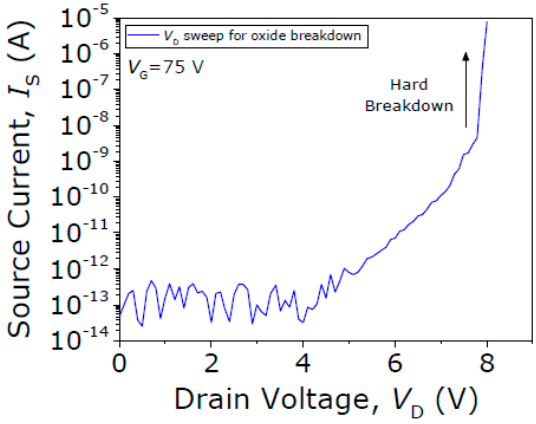
Figure 13. Current versus drain voltage curve in pull-in conditions to produce the initial native oxide breakdown (roughly at V DS = 8 V).